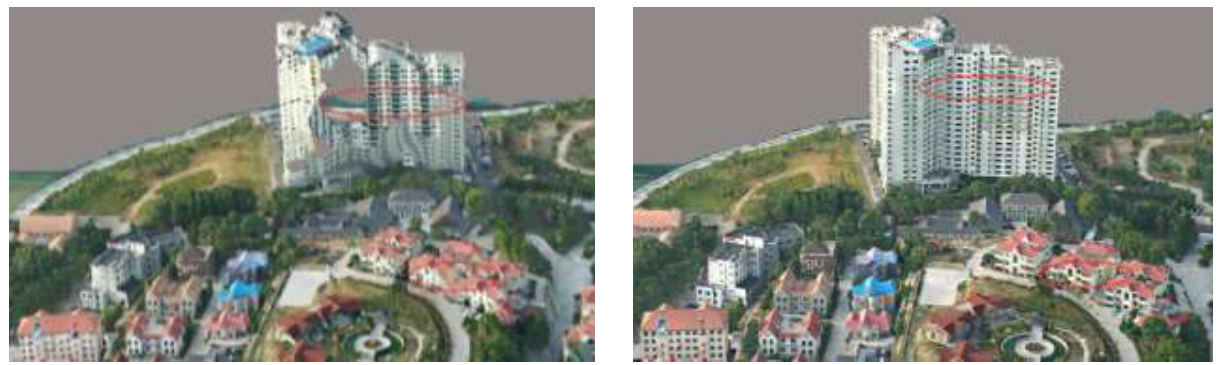
Figure2. Comparison of point clouds generated by different methods